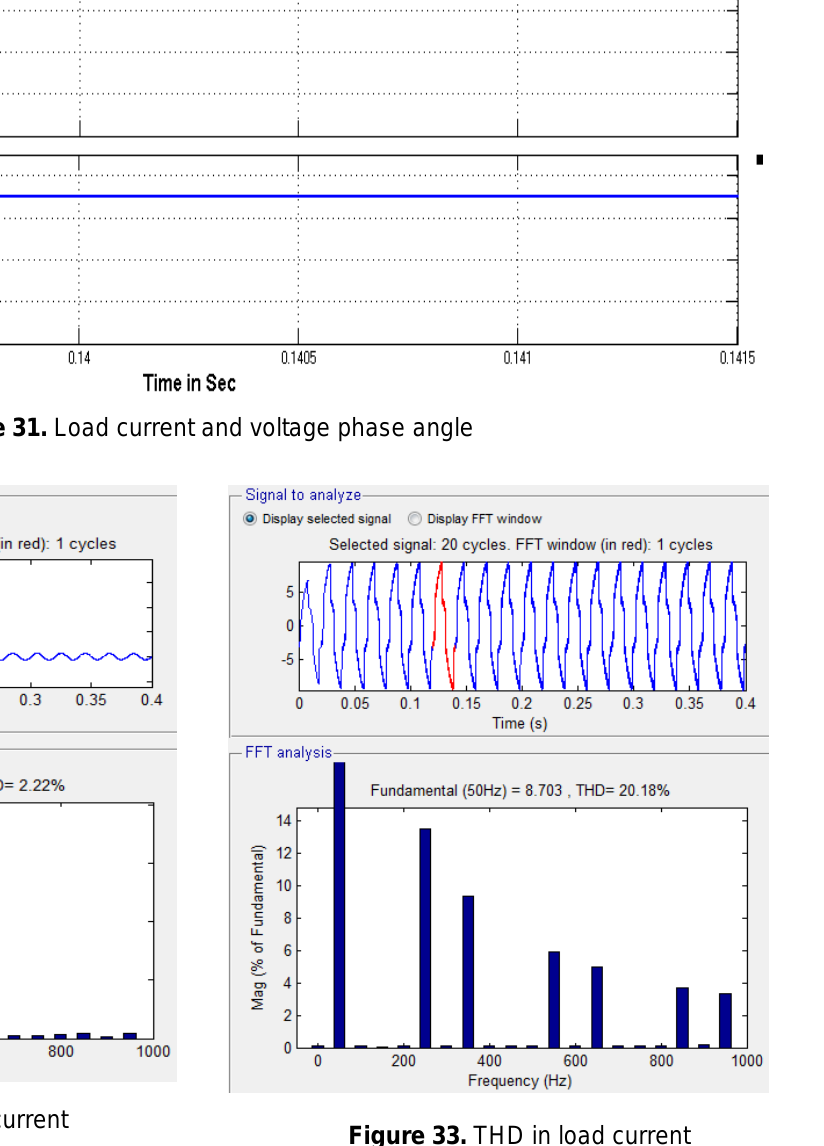
Figure 33. THD in load